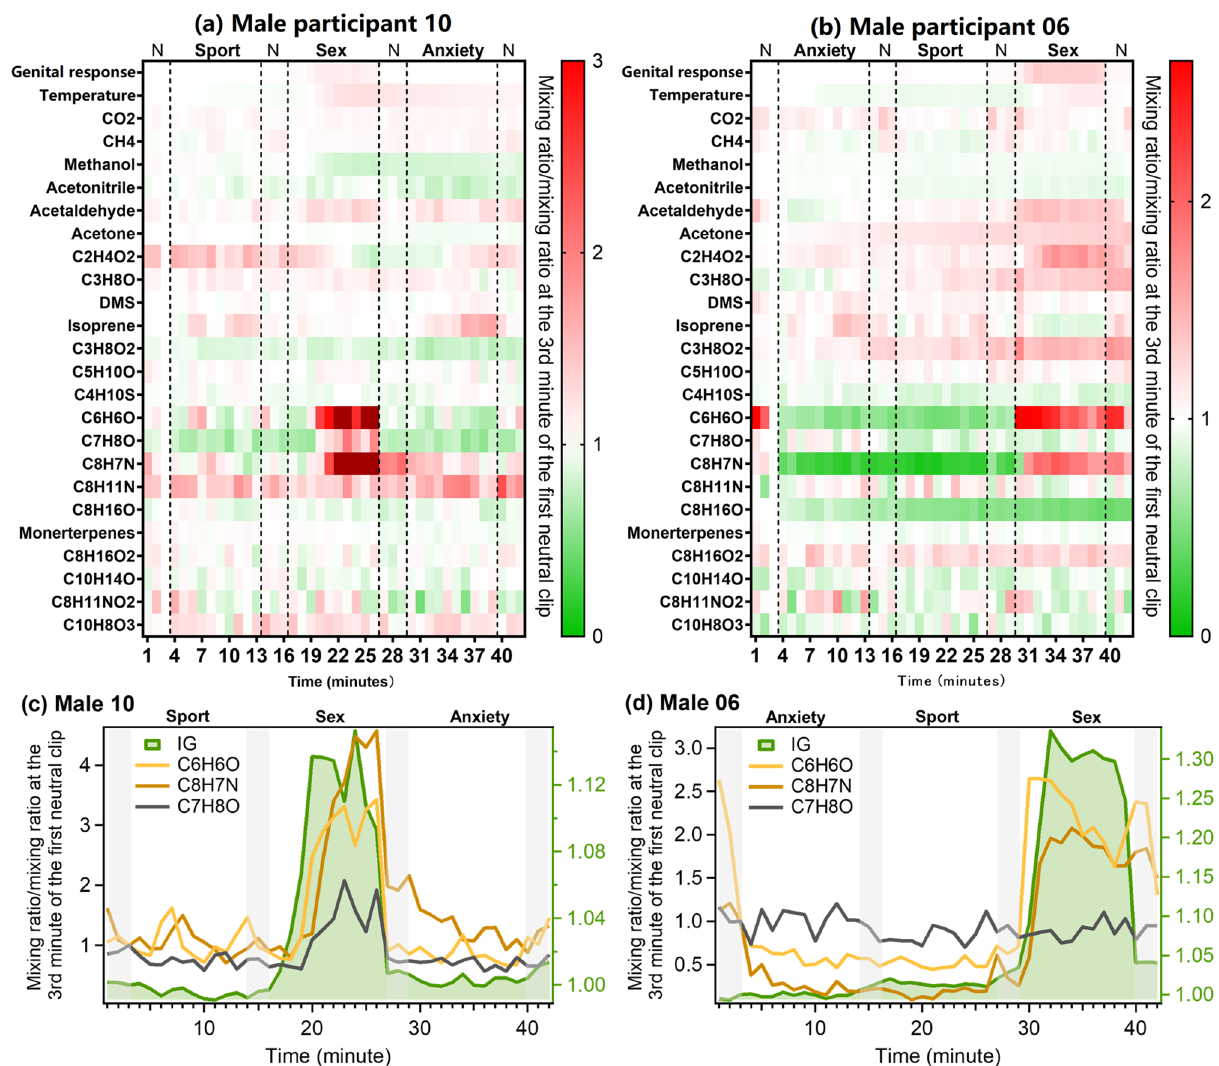
Figure 5. Heat plot of breath compounds together with genital response (penile circumference, IG) and temperature (glans of the penis) of ( a ) male volunteer No. 10 and ( b ) male volunteer No. 06 over the experimental time and time series of selected VOCs having large variations for ( c ) male volunteer No. 10 and ( d ) male volunteer No. 06. Shaded area in ( c ) and ( d ) represents the time when neural clips were